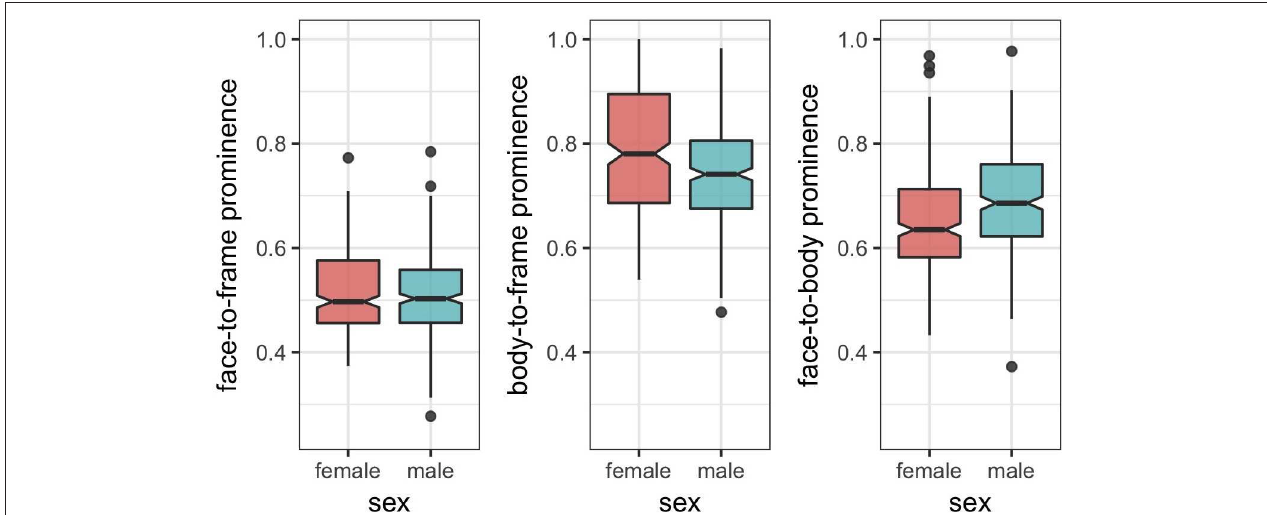
FIGURE 6 | Assessing the prominence of face and body relative to each other and to the picture frame. The box-plot are distributions of the f/p, b/p, and f/b ratios (as defined in Figure 3 ) in our collected selfies. The central horizontal lines identify the median of the distribution, whereas the notches locate the limits of 95% confidence intervals around the medians. The top and bottom of the boxes delimit the central 50% of the data, vertical segments stretch to the minimum and maximum, and black circles identify